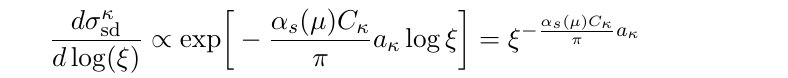
( m ) = 0 . 118 , s Z ( m ) . The start and end points s Z